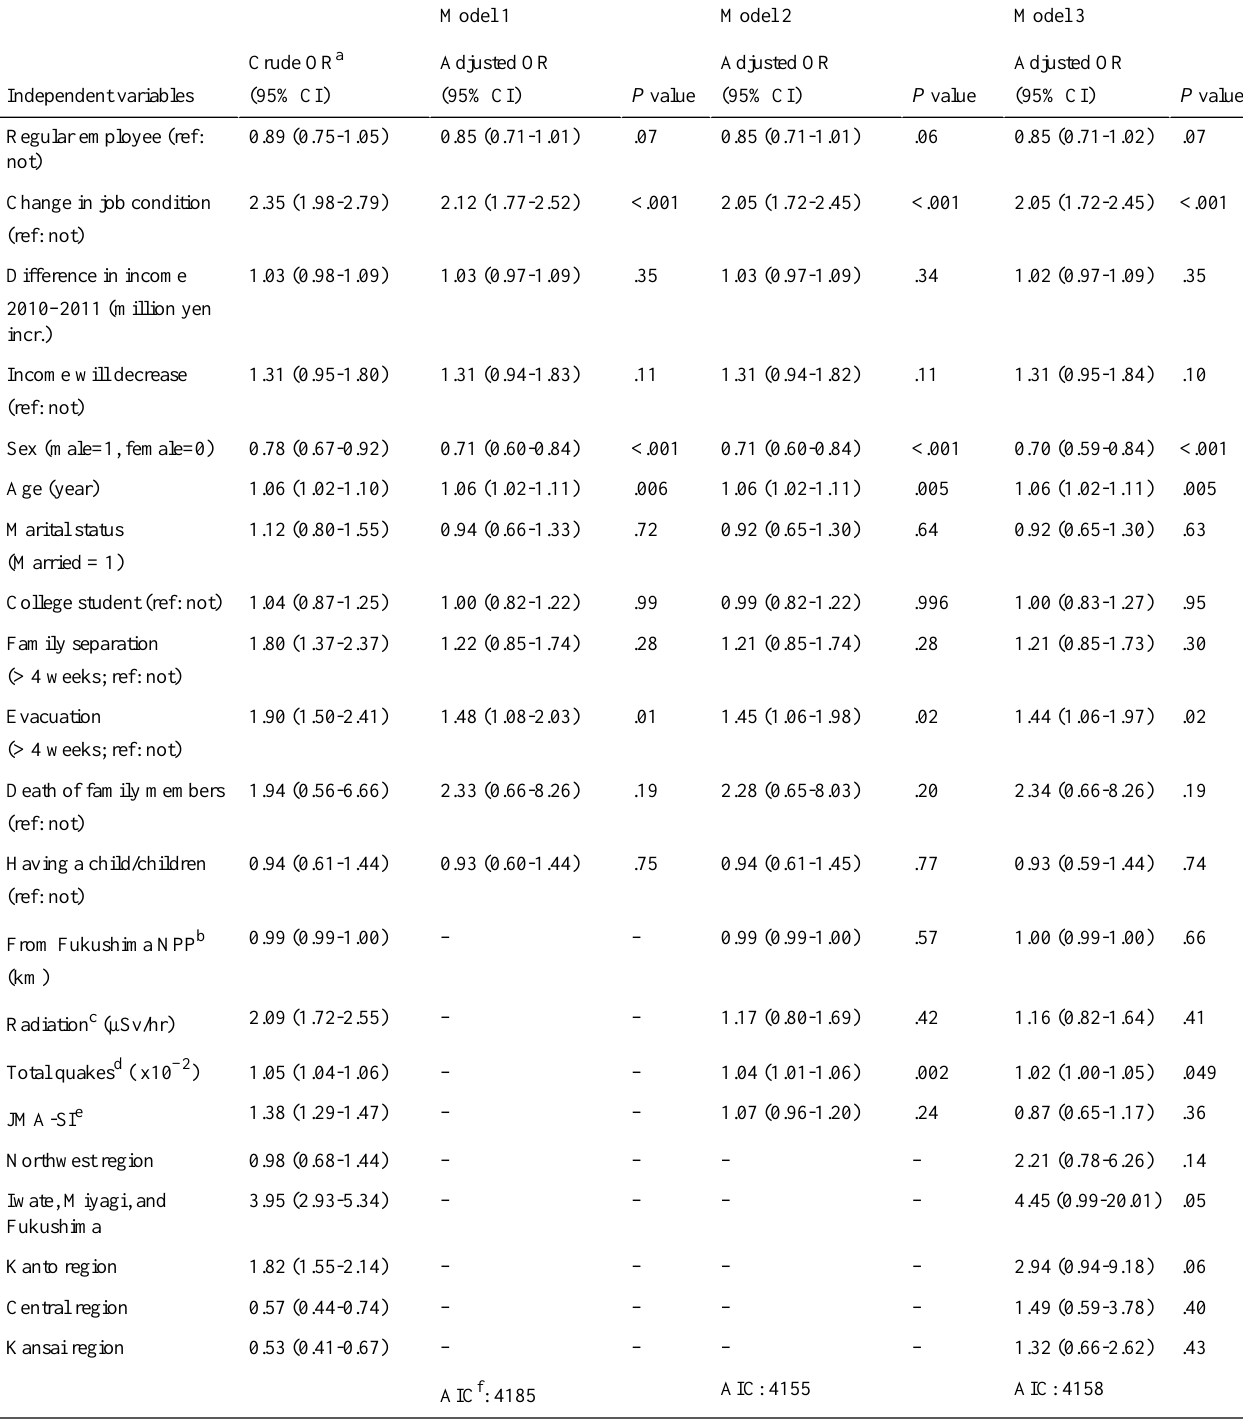
Table 4. Individual- and prefecture-level factors associated with decreased health status: multilevel logistic regression analysis with random-intercept for 47